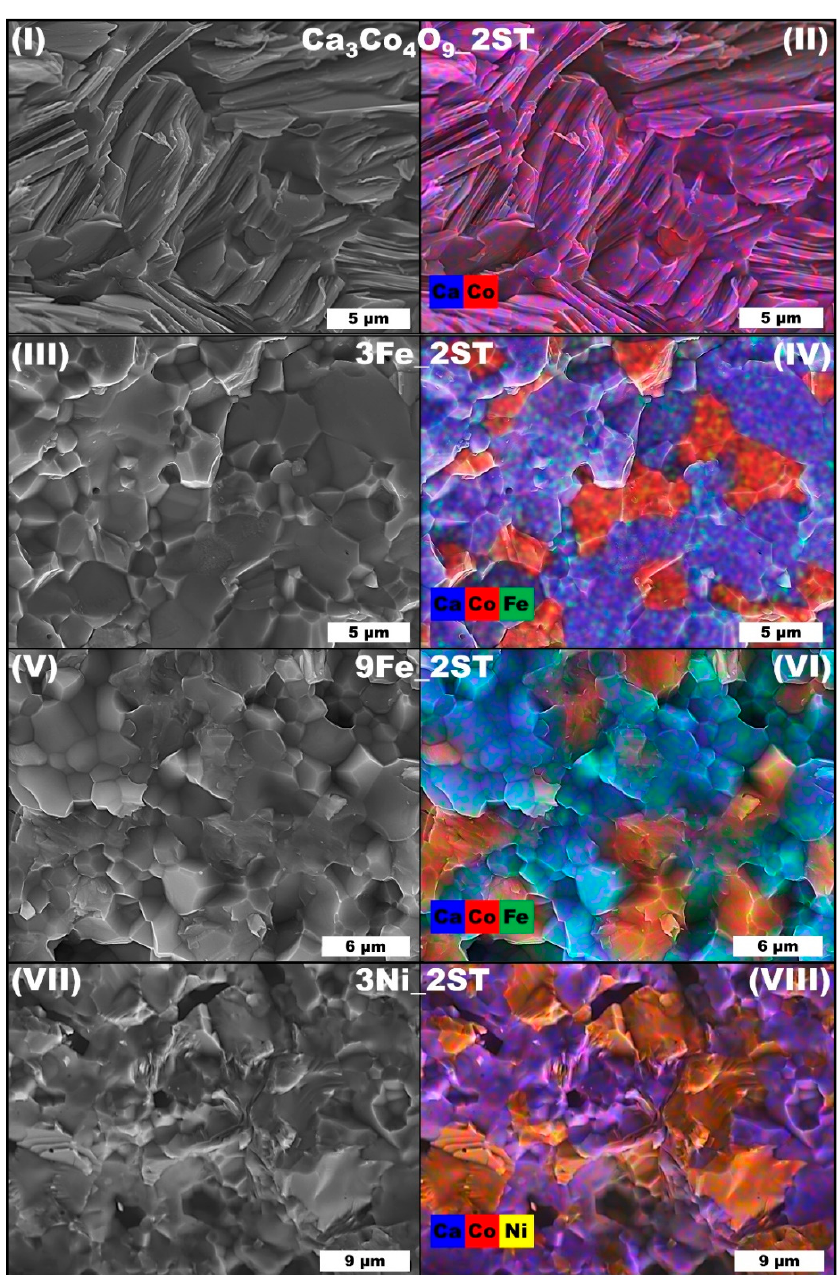
Figure 8. Representative SEM micrographs ( I , III , V , VII ) and EDS maps ( II , IV , VI , VIII ) of selected 2ST sintered samples (fractures).